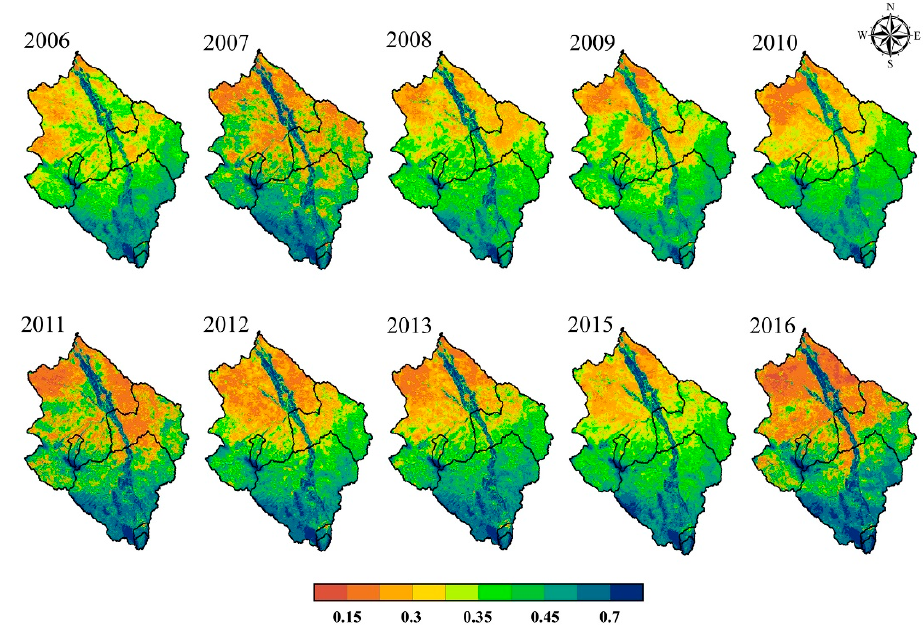
Figure 3. Spatial distribution of the NDVI in the QRB from 2006 to 2016.